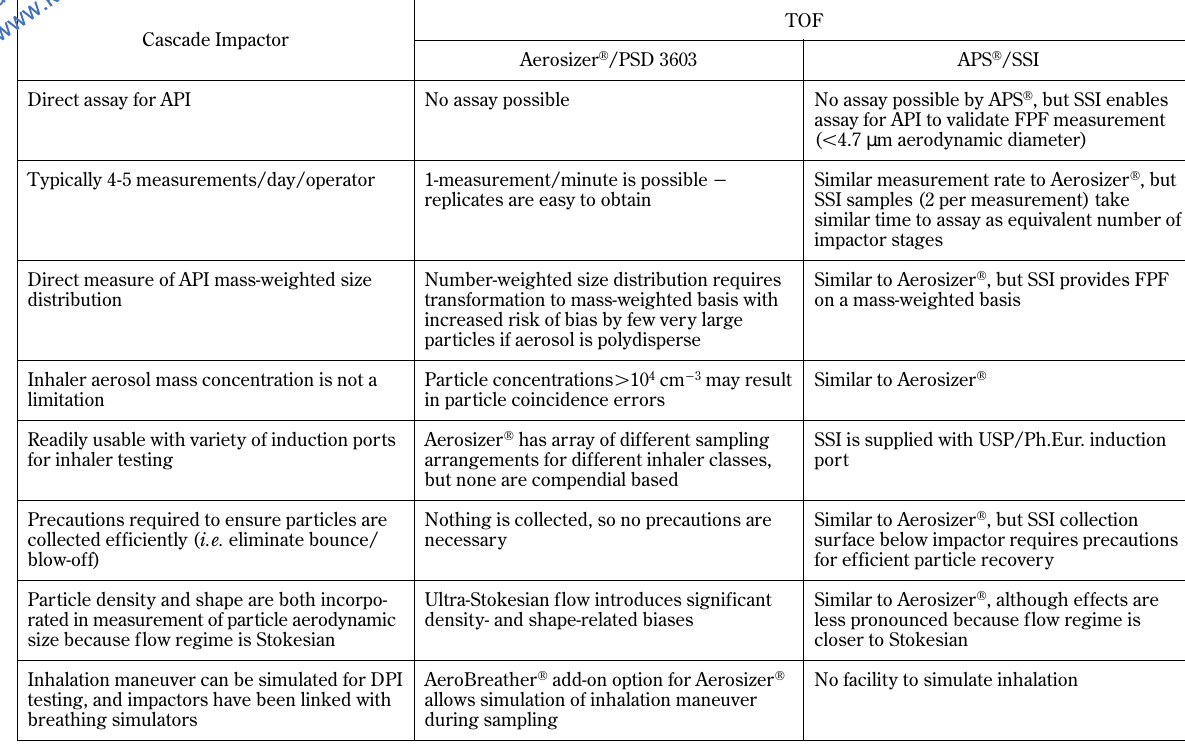
Table 12 Comparison of TOF analysis with cascade impaction